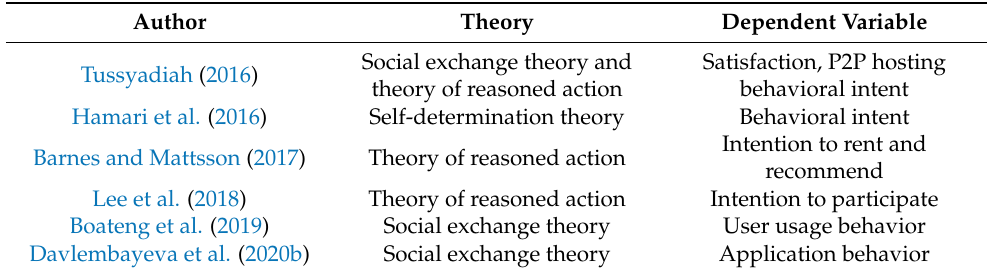
Table 1. Dependent variables that affect consumers’ behavior in the sharing